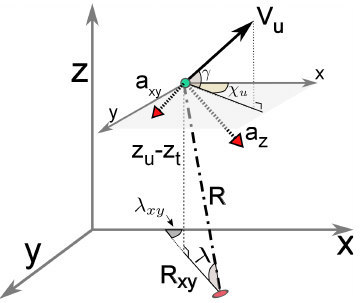
Figure A2. UAV target engagement geometry for 3D landing